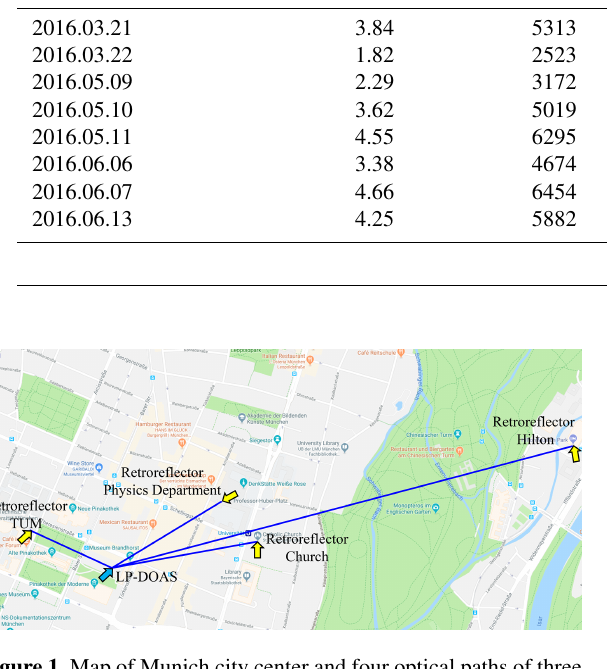
Figure 1. Map of Munich city center and four optical paths of three LP DOAS instruments. Map data © Google